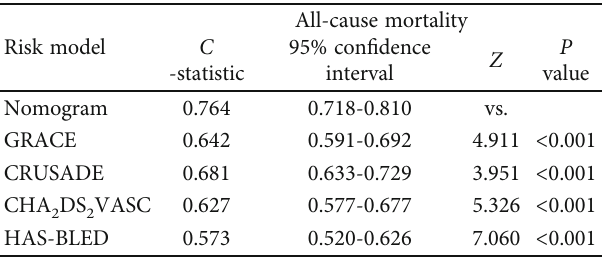
Figure 2: ROC curve of the GRACE, CRUSADE, CHA HAS-BLED, and nomogram to predict all-cause mortality in primary cohort. Table 3: C -statistics of the GRACE, CRUSADE, CHA HAS-BLED, and nomogram to predict all-cause mortality and comparisons of the predictive accuracy of the risk scores for all- cause mortality by DeLong test in primary